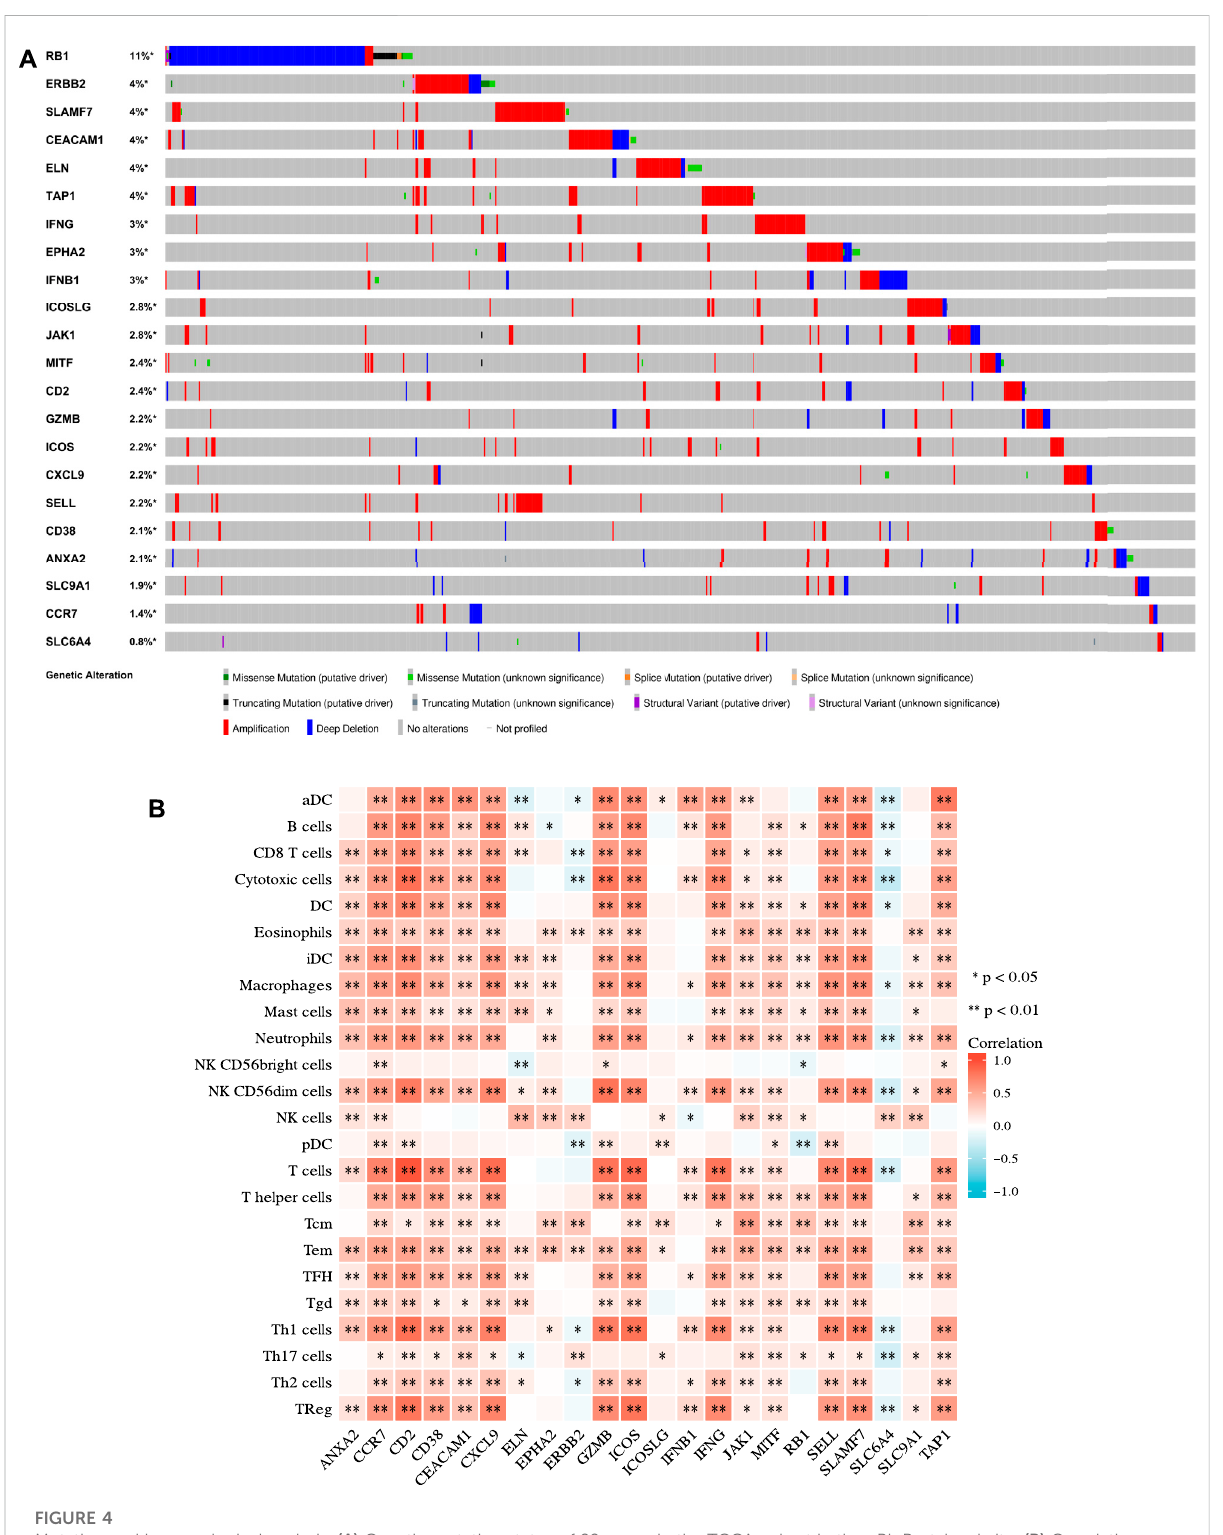
FIGURE 4 Mutation and immunological analysis. (A) Genetic mutation status of 22 genes in the TCGA cohort in the cBioPortal website. (B) Correlation between 22 ICD-related prognosticgenes and24typesofimmune cells calculated bythessGSEAalgorithm. p values are p ≤ 0.5(*), p ≤ 0.01 (**), p ≤ 0.001